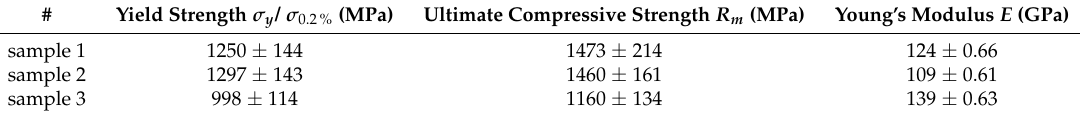
Table 1. Summary of structural and mechanical data: grain size d , yield strength σ y / σ 0.2% , ultimate compressive strength R m , and Young’s modulus E . For sample 1 the strain burst event